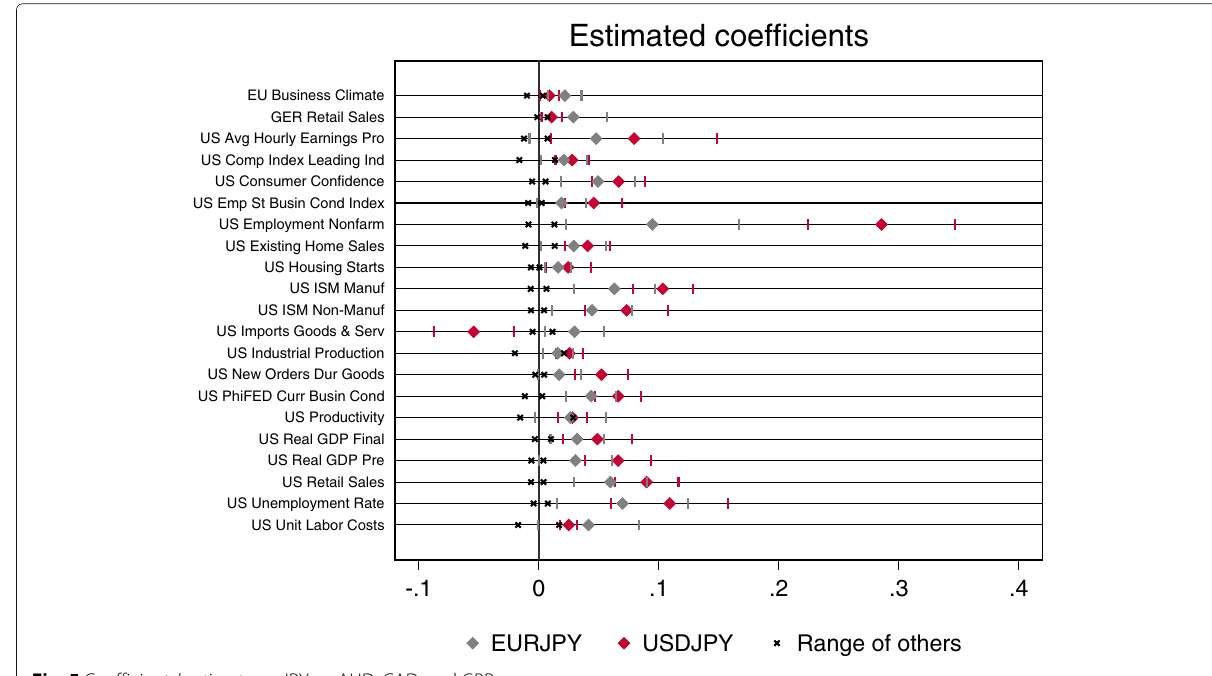
Fig. 5 Coefficients’ estimates—JPY vs. AUD, CAD, and